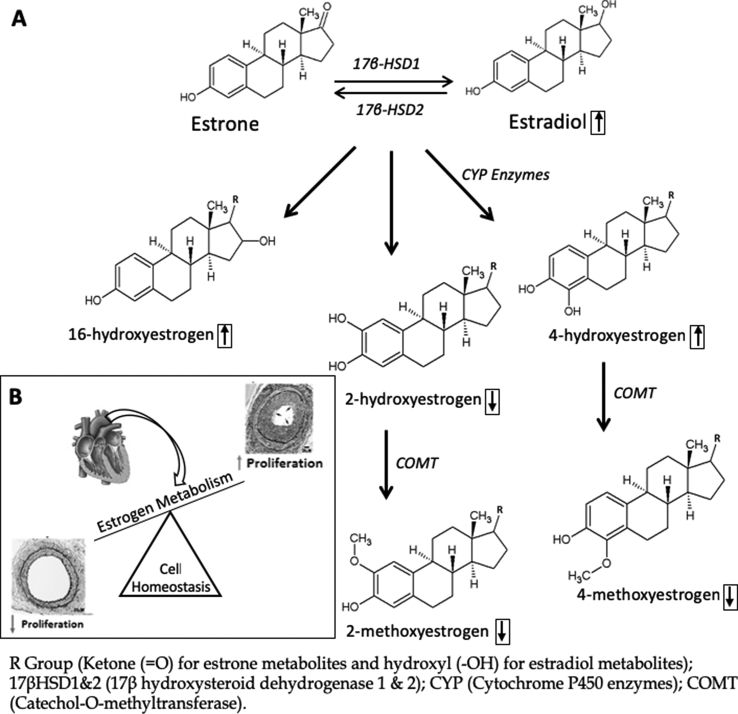
Estrogen metabolism; (A) The estrogen metabolism pathway, where parent estrogens, estrone and estradiol, are interchangeable by the action of 17β-HSDs prior to biotransformation by various cytochrome P450 enzymes inducing hydroxylation reactions in the 2′, 4′ or 16′ positions to form hydroxyestrogens. Rapid conversion/deactivation of the 2 and 4 hydroxylated estrogens then occurs via the action of COMT enzyme causing methylation in 2′ or 4′ positions. (B) Cardiovascular effects of imbalances in estrogen metabolism on normal cell homeostasis thought to drive both proliferative and antiproliferative cell phenotypes within the vasculature.